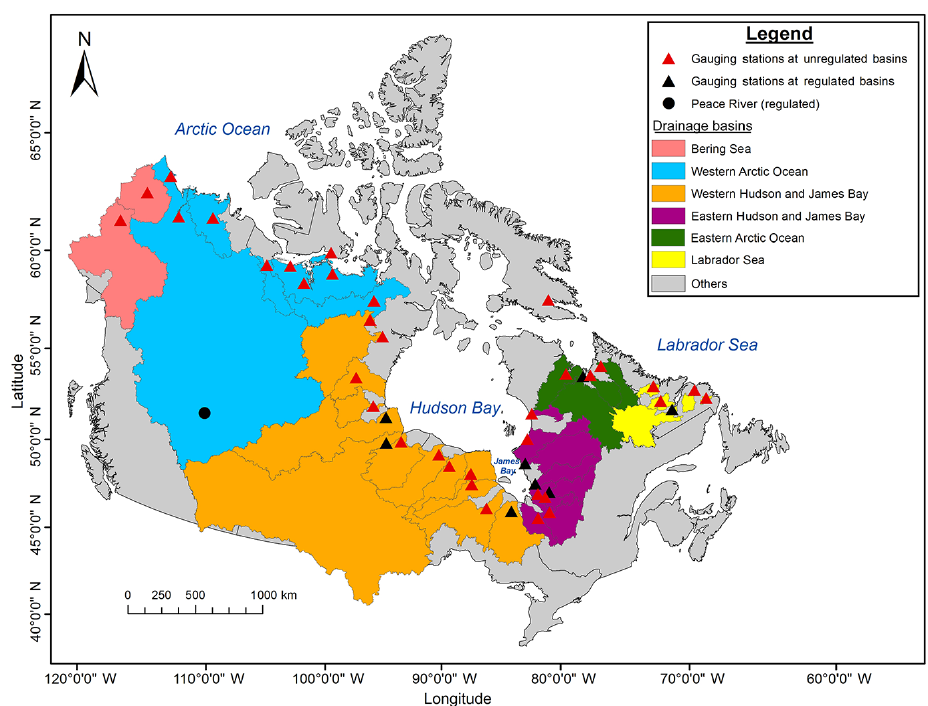
Figure 1. Map of the six major basins draining northern Canada and parts of the northern United States as well as the spatial distribution of hydrometric gauges used in this